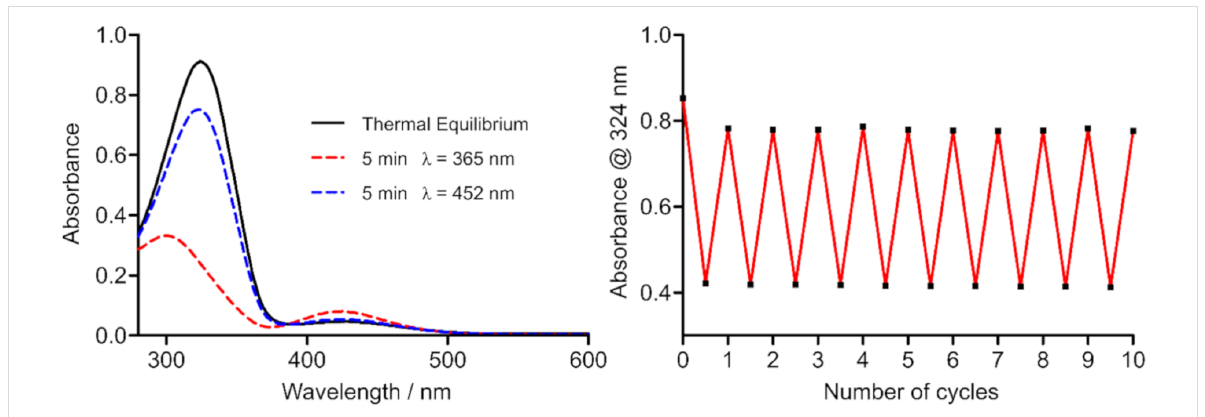
Figure 5: (Left) UV–vis spectrum of 11 , 50 µM in 5% DMSO (v/v), in assay buffer at the thermal equilibrium and the photostationary states (PSS) after 365 nm or 452 nm radiation. (Right) Fatigue resistance of 11 , 50 µM in 5% DMSO (v/v), in assay buffer over 10 cycles of alternating 365 nm and 452 nm radiation.